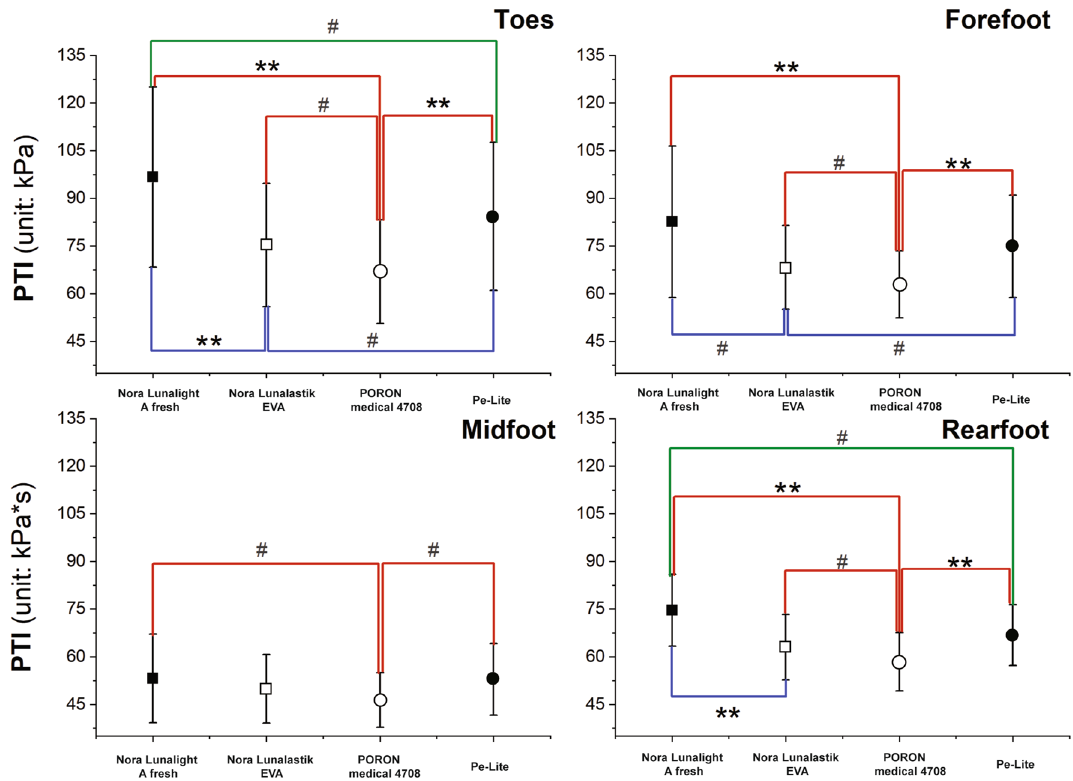
Figure 5. PTI in four different plantar regions with use of four insoles. Notes: # P < 0.05 and ** P <